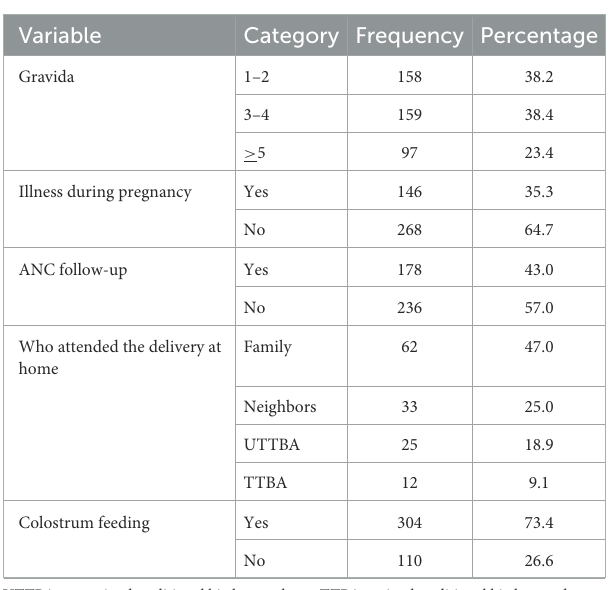
TABLE 2 Obstetrical characteristics of study participants to assess cultural malpractice during the perinatal period in southwest